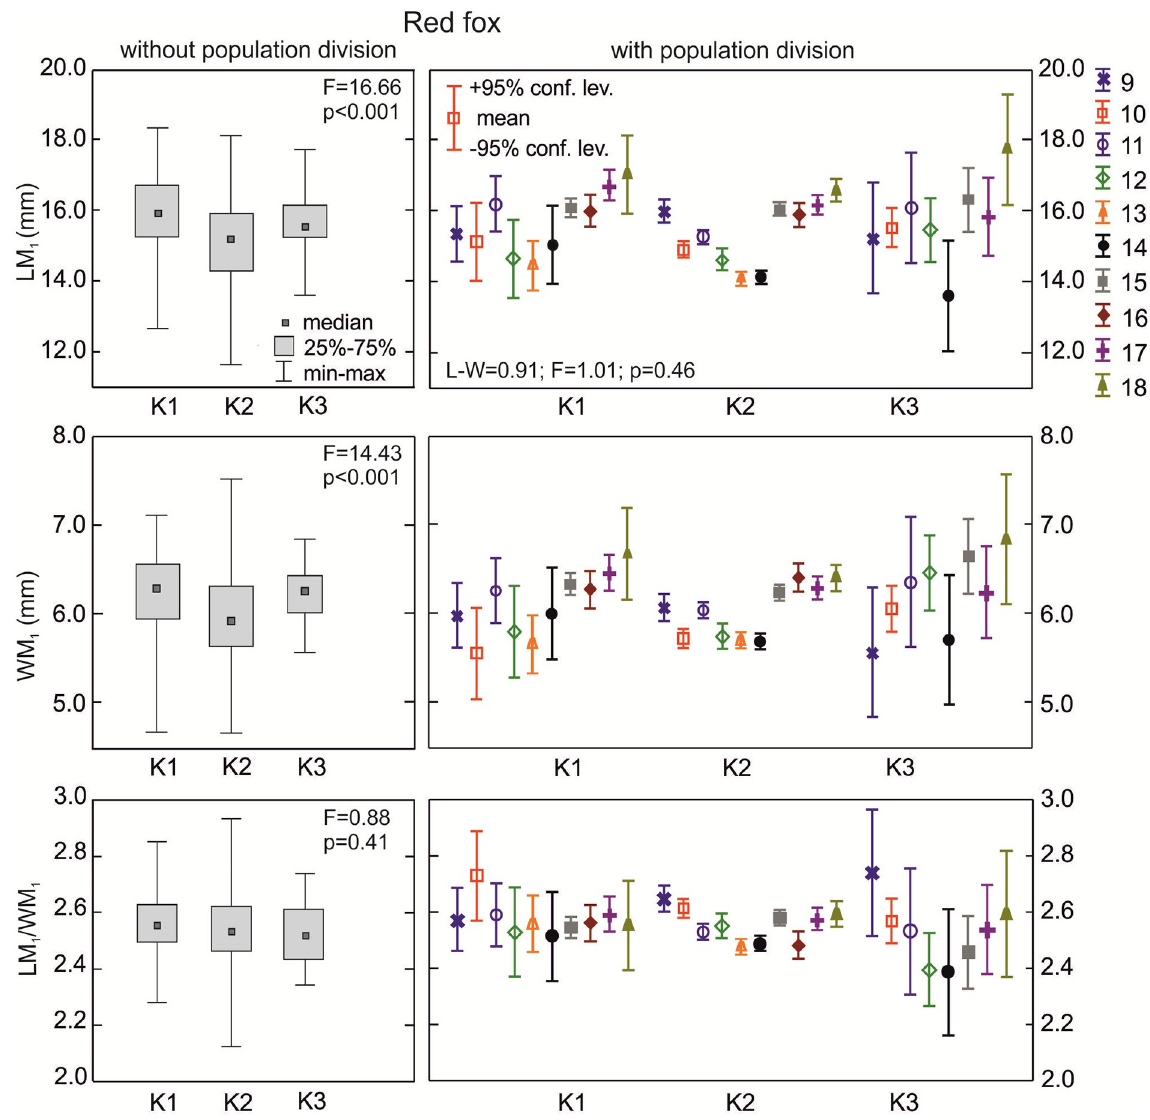
Fig 6. Comparison of median values for length, width, and size proportion of M 1 between various group K morphotypes in the red fox with and without population division. Illustrations of group K morphotypes are shown in Fig 2. Information about the samples can be found in Table